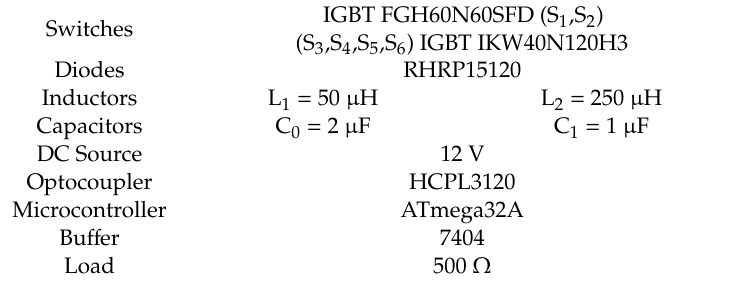
Table 11. Specifications of the prototype setup